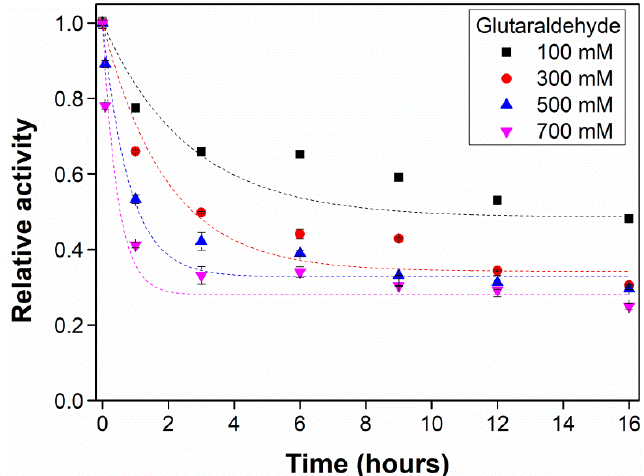
Figure 7. Profile of enzymatic inactivation as a function of glutaraldehyde concentration in the presence of 1% ( w / v ) starch. Assay conditions: water/enzyme solution volume ratio of 9:1 (in 100 mM carbonate buffer pH 10.0), glutaraldehyde concentration ranging from 100 to 700 mM, incubated statically in a refrigerator at 4 ◦ C. Activity of amyloglucosidase was measured with 1% ( w / v ) dextrin in 50 mM sodium citrate buffer pH 4.5, 10 min reaction at 55 ◦ C under 900 rpm stirring. Values correspond to a single assay with activity values measured in duplicate.